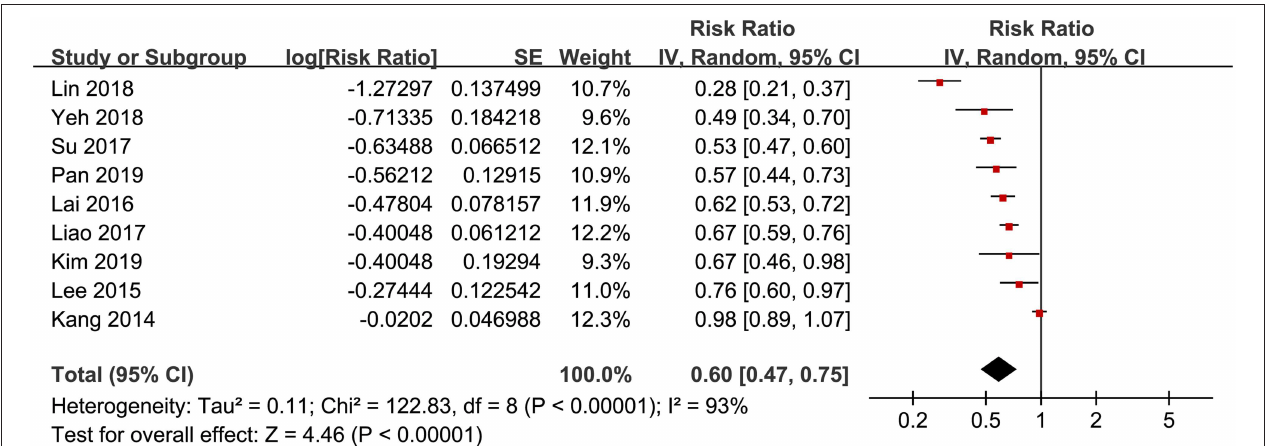
FIGURE 2 | Forest plots for the meta-analysis of the association between statin use and active tuberculosis